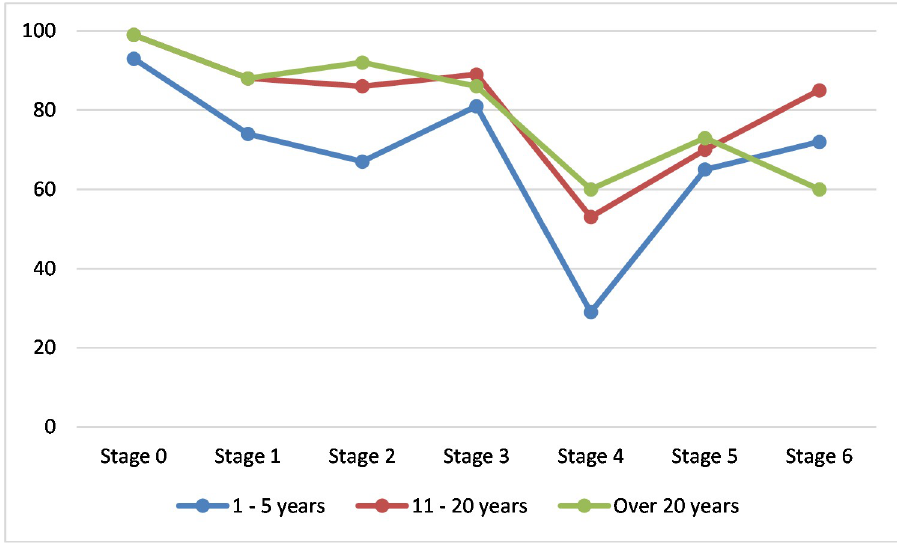
Fig 2. SoC intensity according to years of teaching